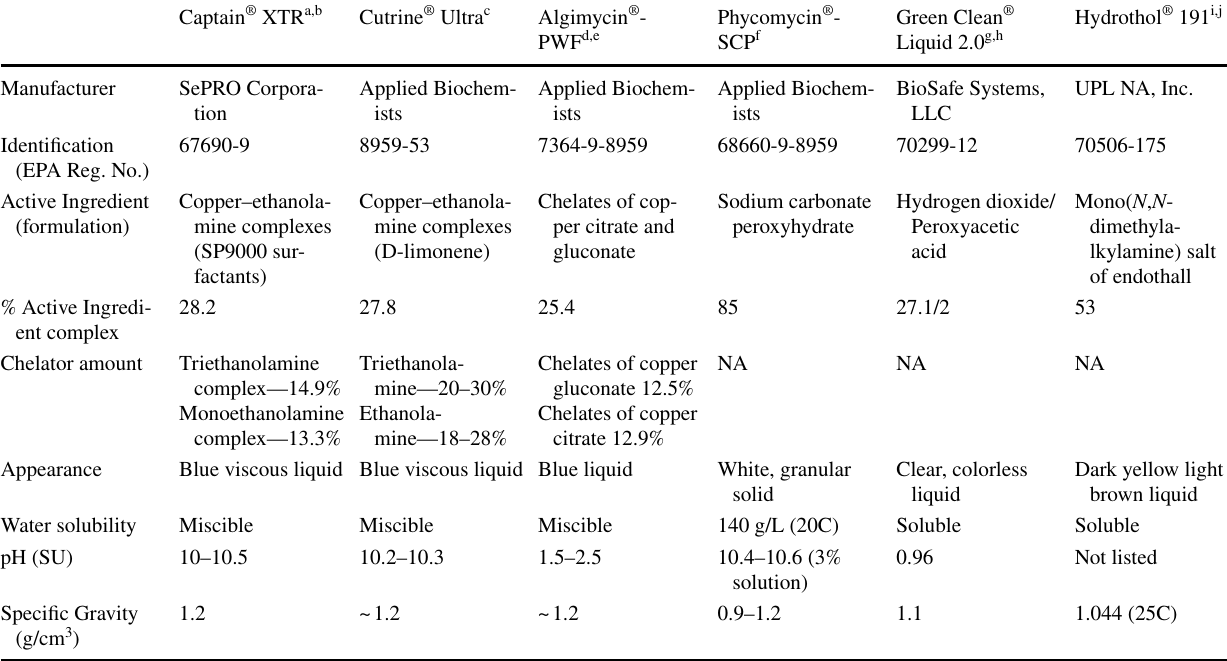
Table 1 Comparison of physical and chemical properties of the primary algaecide formulations tested in attempts to control L.